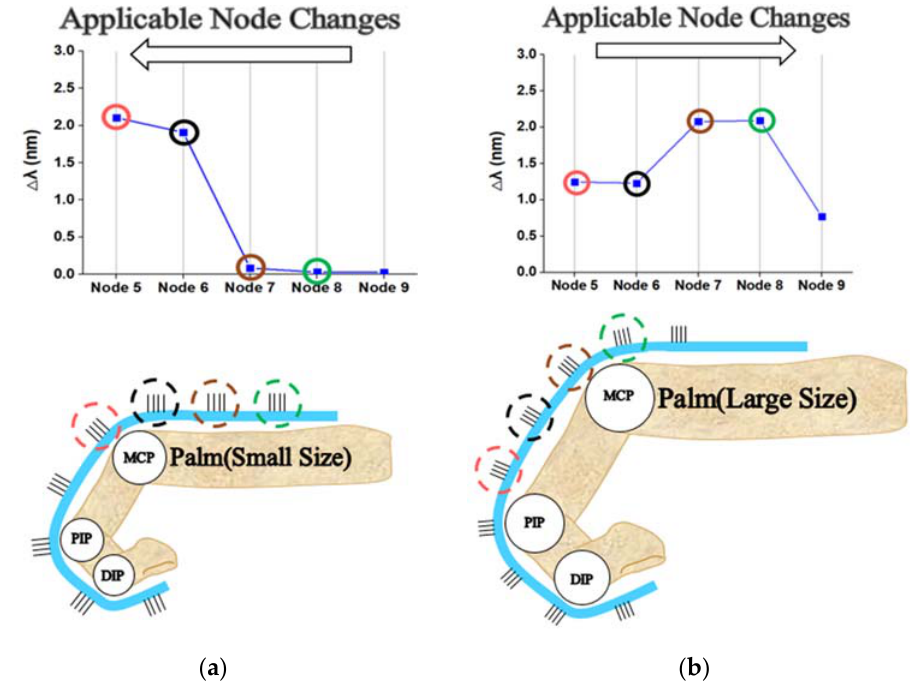
Figure 6. Peak shift changes of five nodes applicable to the MCP joint with different hand sizes: ( a ) Smaller (77 mm) and ( b ) larger (117 mm).